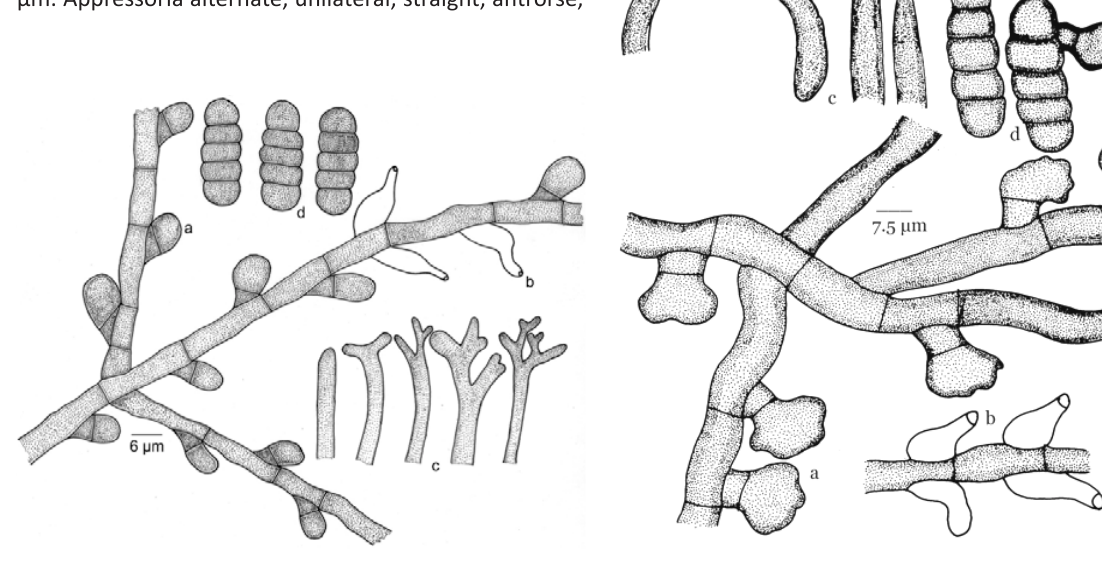
Figure 86. Meliola kamettiae a - Appressorium; b - Phialide; c - Apical portion of mycelial setae; d - Ascospores